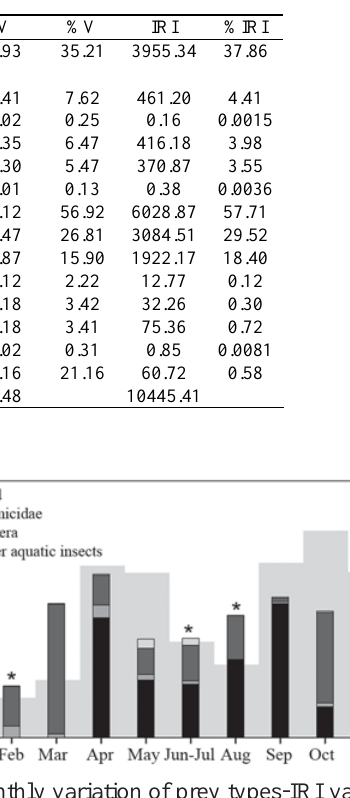
Table 1. Diet of Creagrutus guanes . N = number of each prey item, %N = Percentage of N, F = number of guts containing